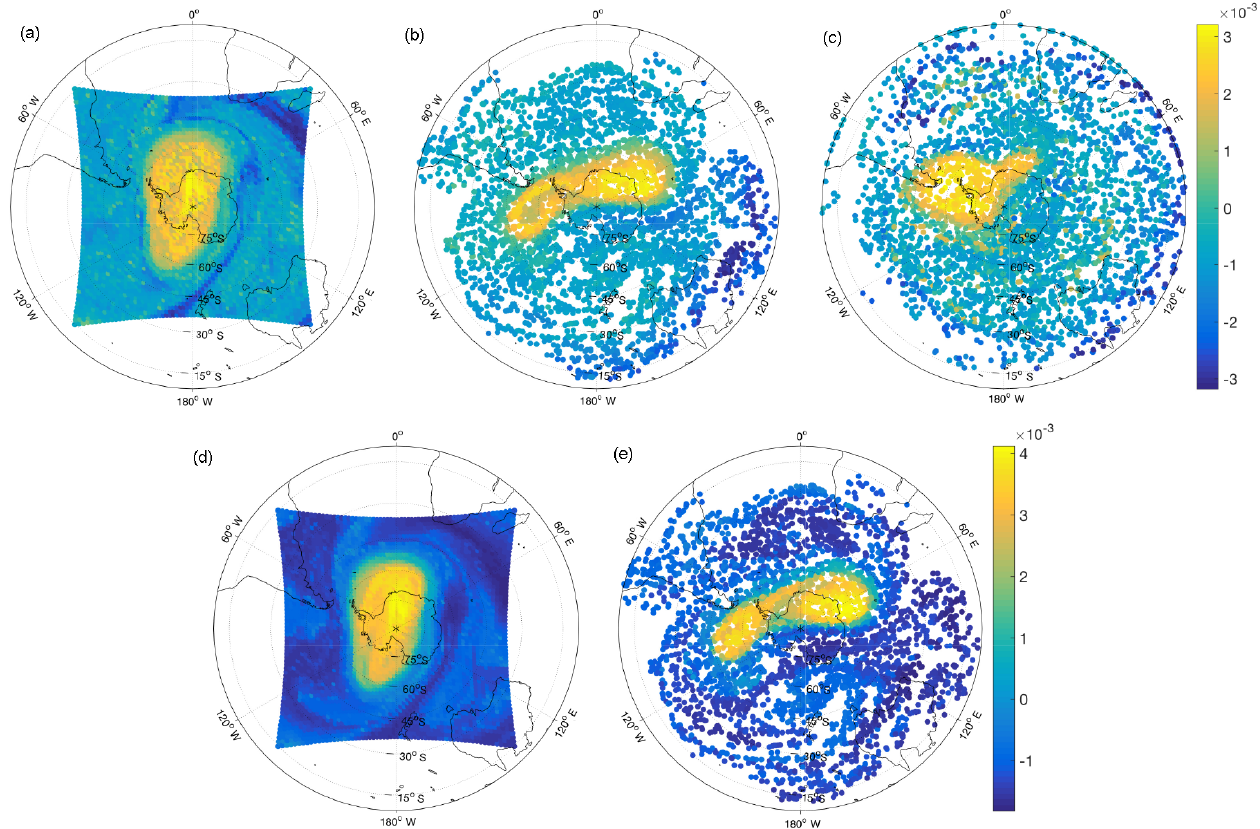
Figure 8. Eigenvector v 2 of the generalized graph Laplacian eigenvalue problem for the polar vortex example from trajectories computed on two different time spans ( a–c : 1 September to 31 October 2002; d and e : 1–26 September 2002). Top row: particles at 1 September 2002 (a) ; 26 September 2002 (b) ; 31 October 2002 (c) . Bottom row: particles at 1 September 2002 (d) ; 26 September 2002 (e)